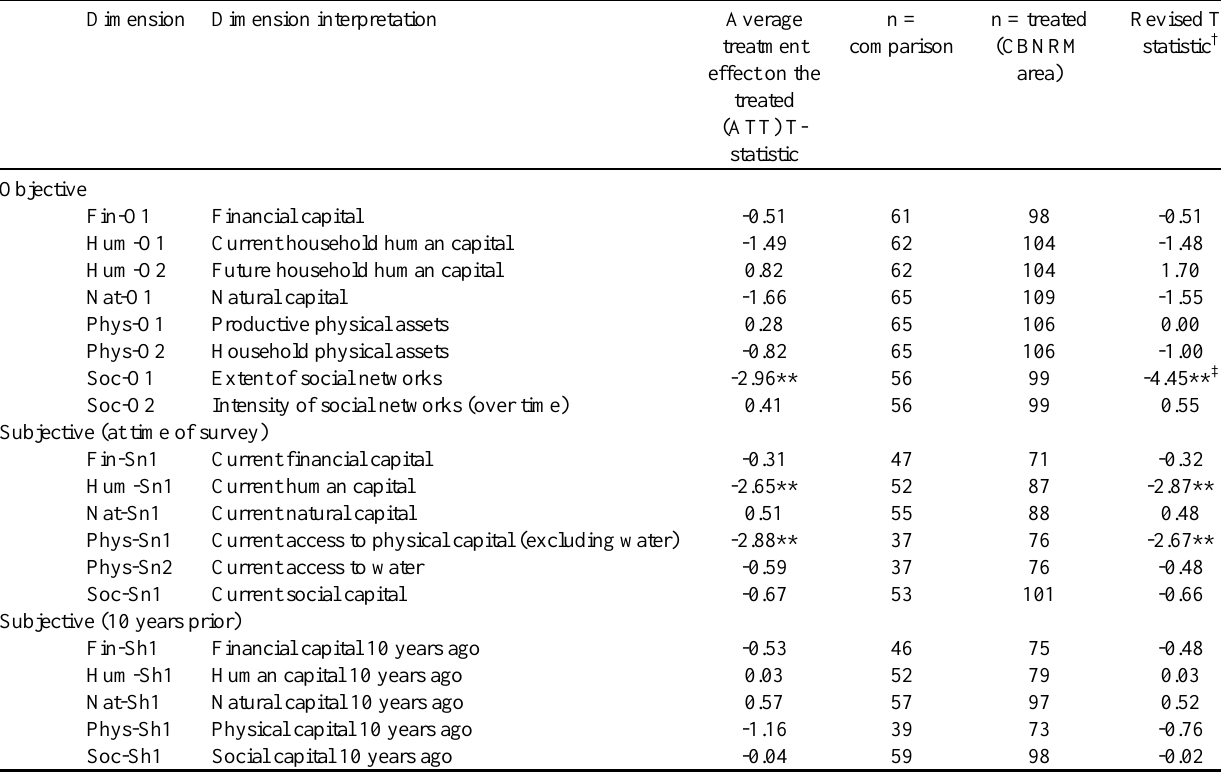
Social capital 10 years